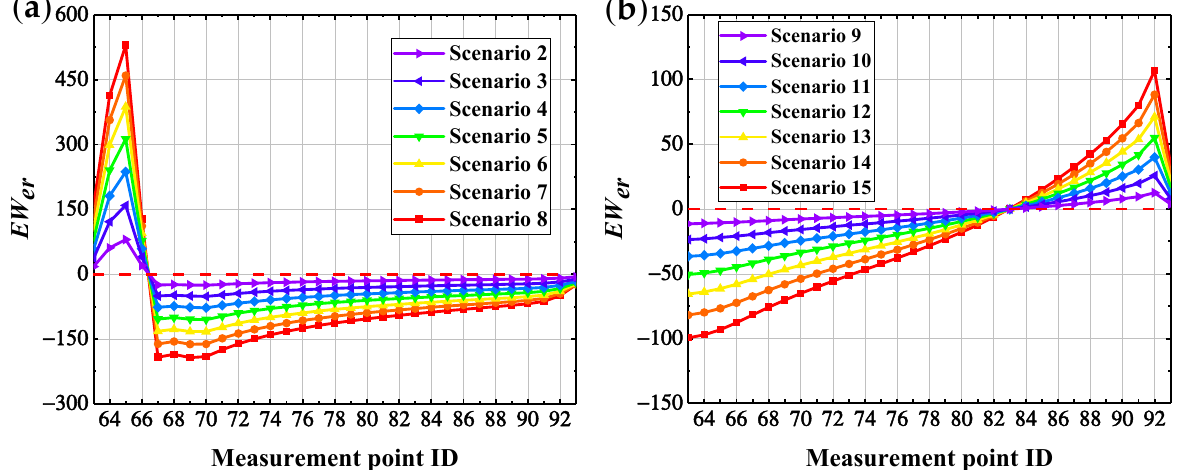
Figure 15. EW er damage identification results:( a ) Damage I; ( b ) Damage II.